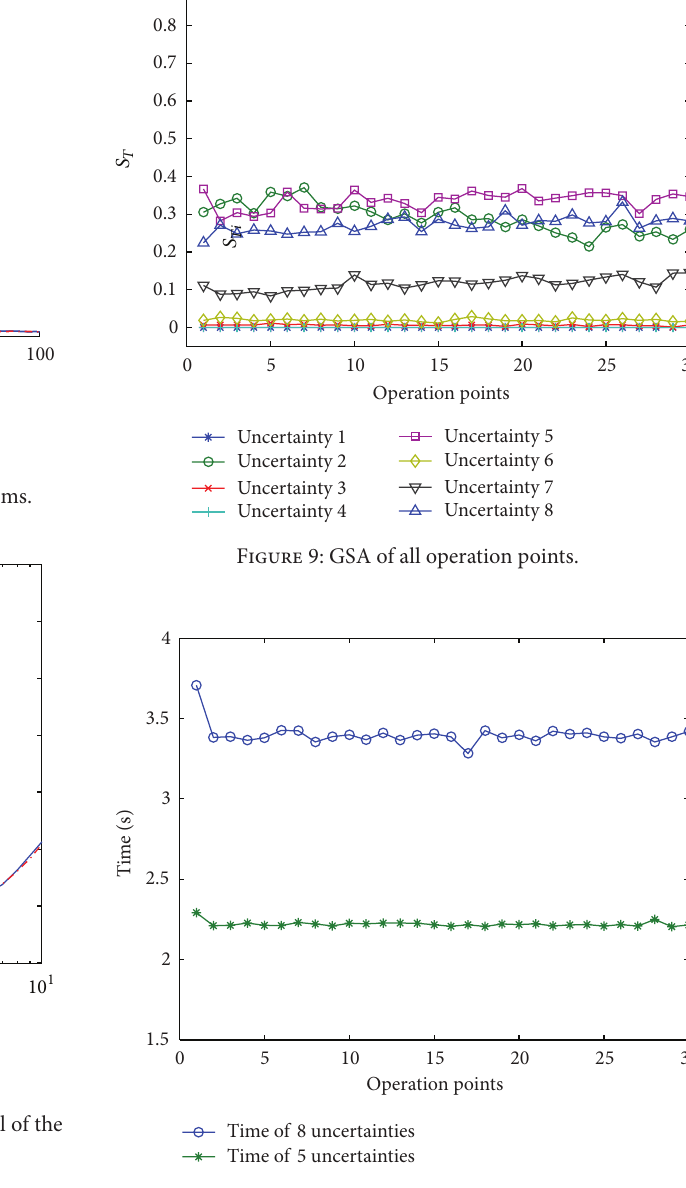
Figure 10: Computational time of 𝜇 for all operation